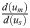
Effect on network structure.(A) Response probability p versus structure of source user us and be-mentioned user um. (B) Response probability p versus structure of two be-mentioned users um1 and um2. From (a)(b), we can both observe that the response probability is the highest when a reciprocal followship exists between users. (C) Response probability p versus degree ratio d(um)d(us), where d(um) represents the number of followers of be-mentioned user um and d(us) is the number of followers of source user us. We find that the response probability of the degree ratio between [0.1, 10) is higher than the others.